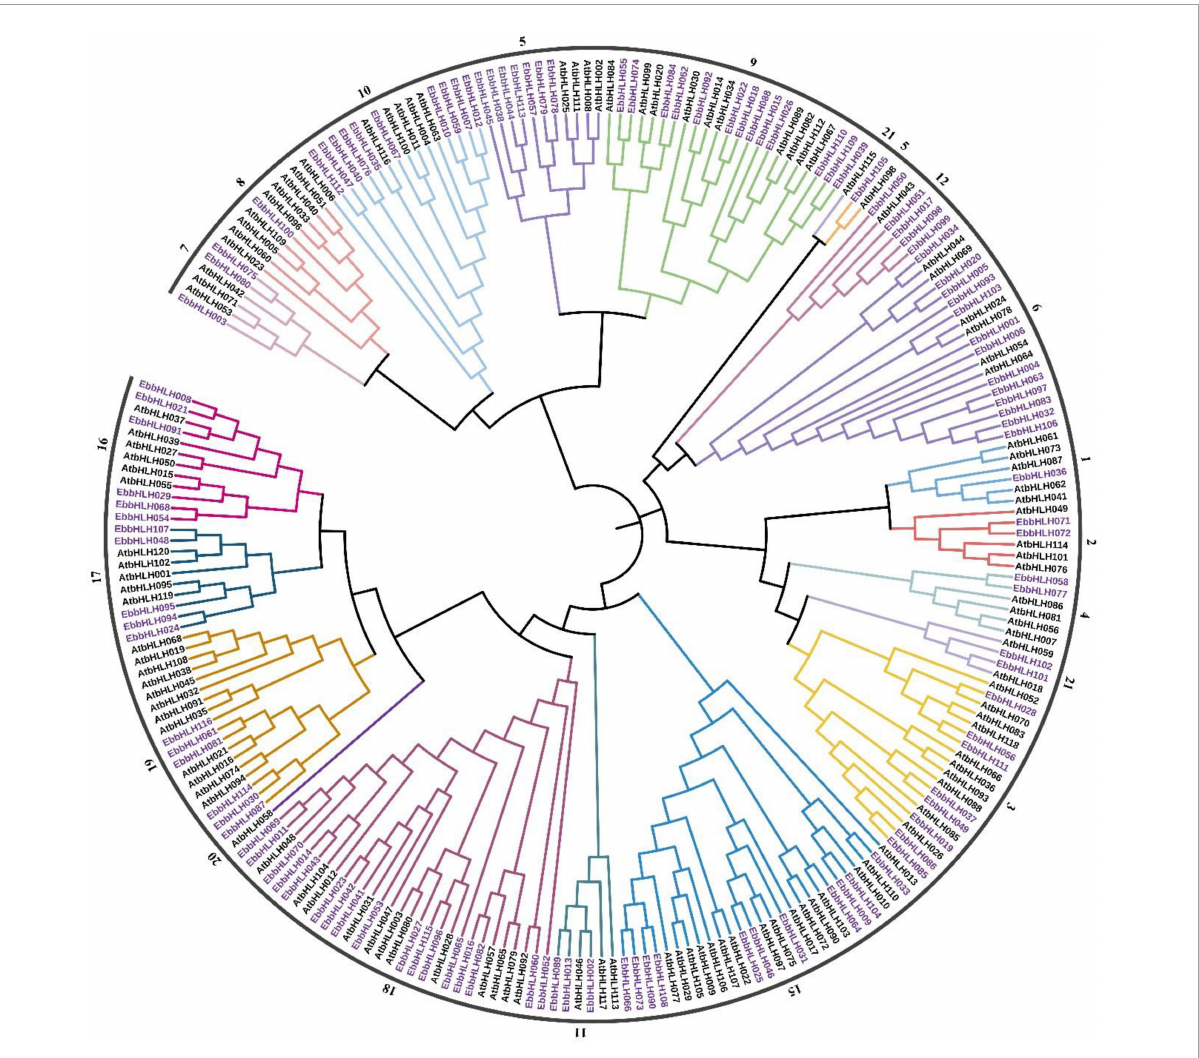
FIGURE3 Phylogenetic tree between E. breviscapus and Arabidopsis thaliana . The phylogenetic tree was obtained using the NJ method in MEGA7. The tree shows 21 phylogenetic subfamilies, each subfamily represented by different colors. bHLH protein from Arabidopsis is labeled with the prefix